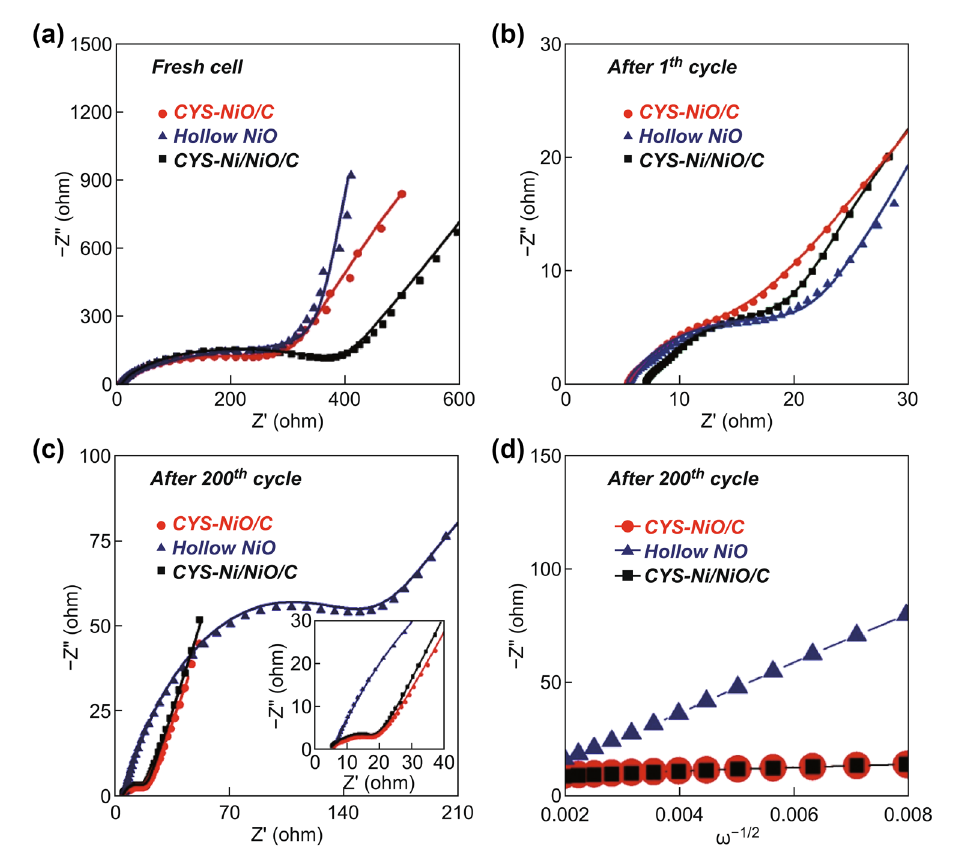
Fig. 8 a – c Nyquist impedance plots (lines represent fitting data) and d relationships between the real part of the impedance ( Z re ) and ω −1/2 of the CYS‑NiO/C, CYS‑Ni/NiO/C, and hollow NiO microspheres: a before cycling, b after the 1st cycle, c, d after the 200th